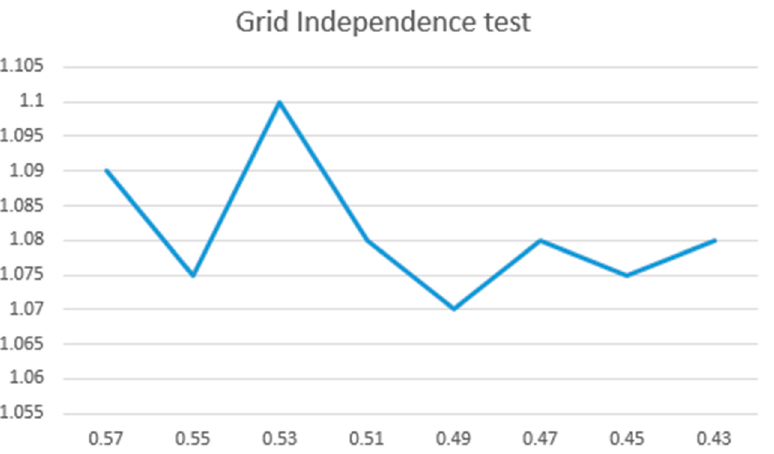
Figure 3. Grid independence test (x axis element size (mm) and y axis maximum pressure (Pa).